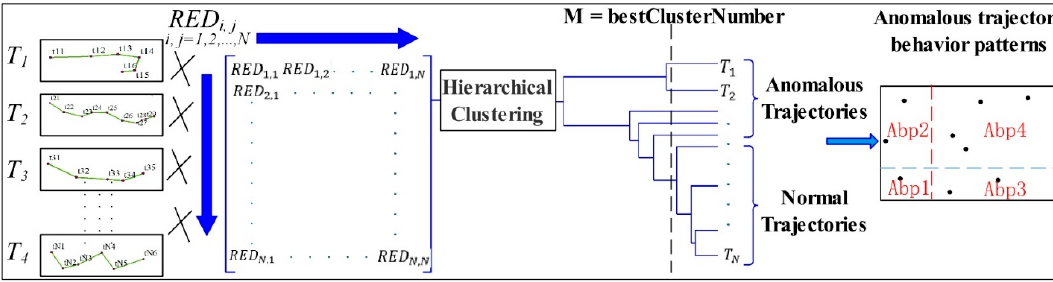
Figure 1. A procedure for the anomalous trajectory detection.